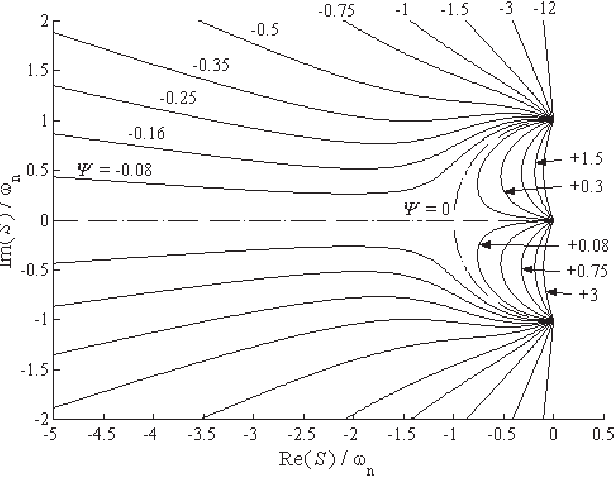
Fig. 1. Root locus of the complex damped SDOF system in function of ψ .